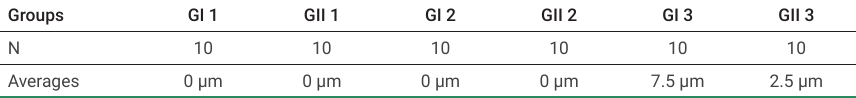
Table 3. Average measurements of the interaction layer between the glass ionomer cement and dentine, according to each treatment group